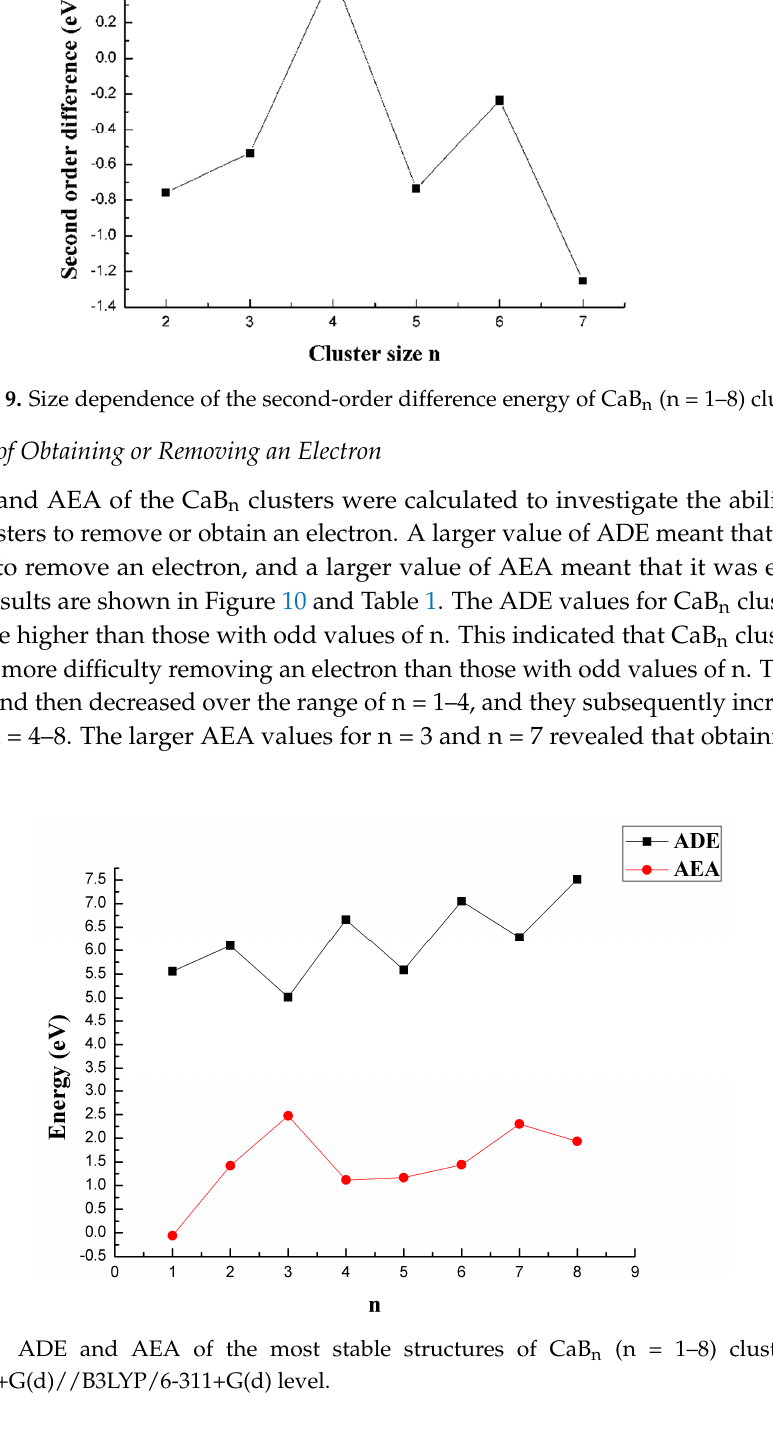
Figure 8. Size dependence of the fragmentation energy of CaB n (n = 1–8) clusters.